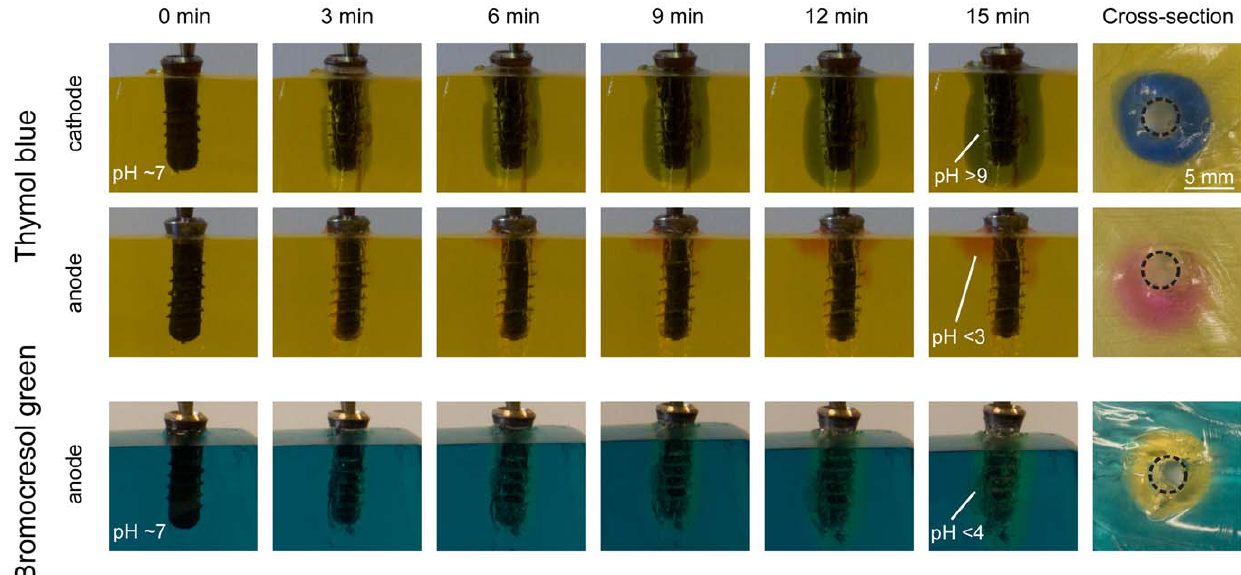
Figure 3. Proof of pH changes during electrochemical implant treatment. Photographic images of dental implants in simulated soft tissue using pH-sensitive dyes to visualize local pH changes. The dark blue color for thymol blue indicated a pH above 9 (alkaline) while the pink color confirmed a pH below 3 (strongly acidic). Confirmation with a second pH-sensitive dye, bromocresol green allowed mapping a similar acidic pH at the anode. For both dyes, a homogenous, circular simulated soft tissue section of high/low pH evolved around the implant insertion hole.